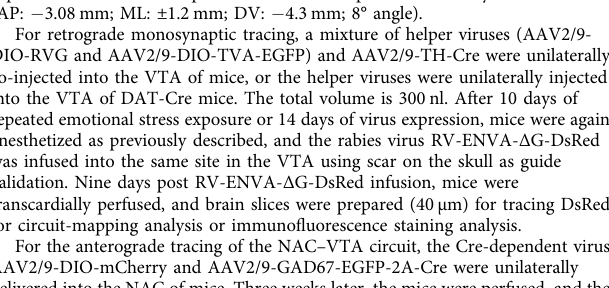
Fig. 7 Bidirectional modulation of NAc – VTA circuit could mimic or reverse the CES-induced anxiety-like behavior. a – k Inhibition of NAc – VTA circuit directly triggers anxiety-like behavior. a Schematic representation of in vivo virus infection and optical fi ber implantation. b Experimental scheme. c Starter cells (yellow) in NAc, which are co-infected by AAV2/9-GAD67-EGFP-2A-Cre (green) and AAV2/9-DIO-mCherry (red). Scale bar, 200 μ m. d The quantitative analysis of Venn diagram shows the co-expression level of EGFP with mCherry in NAc (3 sections per mouse from 4 mice). e – h Results of OFT ( n = 8 mice for each group). e Representative locomotion traces of NpHR or mCherry mice in OFT with laser on or off. f Percentage of time spent in the central area of OFT (two-way ANOVA, group: P = 0.0049, laser: P = 0.0193, interaction: P = 0.0058; post hoc Bonferroni ’ s test, NpHR(off vs. on): P = 0.0036, On(mCherry vs. NpHR): P = 0.0012). g Percentage of distance traveled in the central area of OFT (two-way ANOVA, group: P = 0.0016, laser: P = 0.0322, interaction: P = 0.0079; post hoc Bonferroni ’ s test, NpHR(off vs. on): P = 0.0070, On(mCherry vs. NpHR): P = 0.0007). h Total distance traveled in the OFT (two-way ANOVA, group: P = 0.0938, laser: P = 0.5533, interaction: P = 0.7353; post hoc Bonferroni ’ s test, NpHR (off vs. on): P = 0.9999, On(mCherry vs. NpHR): P = 0.9193). i – k Results of EPM ( n = 8 mice for each group). i Representative exploring traces of NpHR or mCherry mice in EPM with laser on or off. j Percentage of time spent in the open arms of EPM (two-way ANOVA, group: P = 0.0177, laser: P = 0.0017, interaction: P = 0.0117; post hoc Bonferroni ’ s test, NpHR(off vs. on): P = 0.0009, On(mCherry vs. NpHR): P = 0.0058). k Number of open-arm entries in the EPM (two-way ANOVA, group: P = 0.3078, laser: P = 0.1770, interaction: P = 0.1770; post hoc Bonferroni ’ s test, NpHR(off vs. on): P = 0.3611, On(mCherry vs. NpHR): P = 0.5857). l – t Activation of NAc – VTA circuit could reverse the CES-induced anxiety-like behavior. l Schematic representation of in vivo virus infection and optical fi ber implantation. m Experimental scheme of bilateral activation of VTA neurons receiving NAc projections and CES modeling. n – q Results of OFT ( n = 10 mice for each group). n Representative locomotion traces of ChR2 or mCherry mice in OFT. o Percentage of time spent in the central area of OFT (two-tailed unpaired t -test, P = 0.0018). p Percentage of distance traveled in the central area of OFT (two-tailed unpaired t -test, P = 0.0052). q Total distance traveled in the OFT (two-tailed unpaired t -test, P = 0.2154). r – t Results of EPM ( n = 10 mice for each group). r Representative EPM traces of ChR2 or mCherry mice. s Percentage of time spent in the open arms of EPM (two-tailed unpaired t -test, P = 0.0005). t Number of open-arm entries in the EPM (two-tailed unpaired t -test, P = 0.0018). The red and blue dots in the OFT and EPM locomotion traces re fl ect the start and end points of the mouse, respectively. All data are shown as mean ± SEM. ns not signi fi cant, ** P ≤ 0.01, *** P